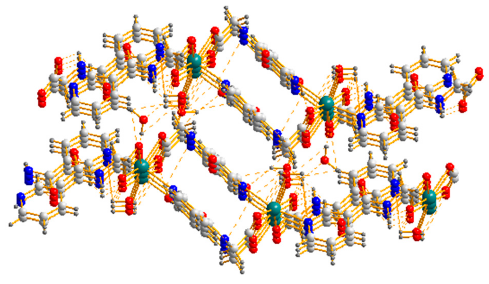
Figure 3. 3D supramolecular network structure.